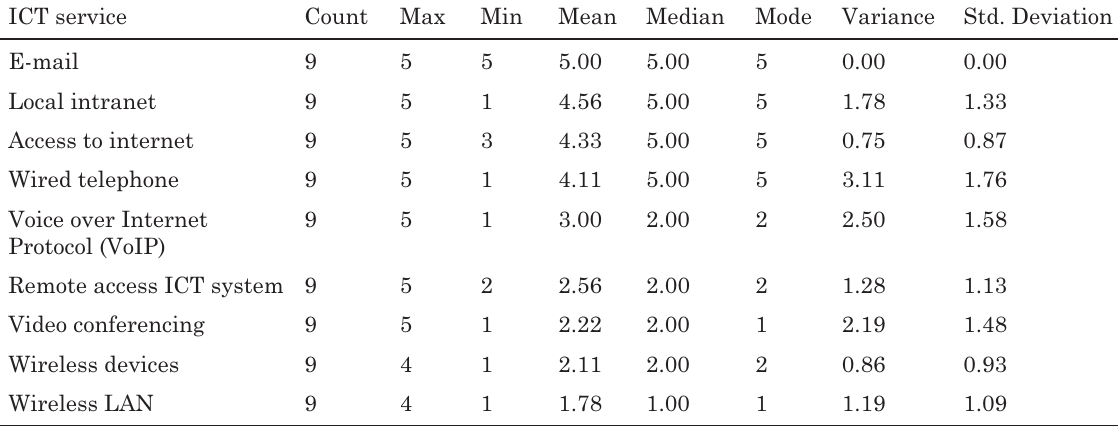
Table 4. ICT users